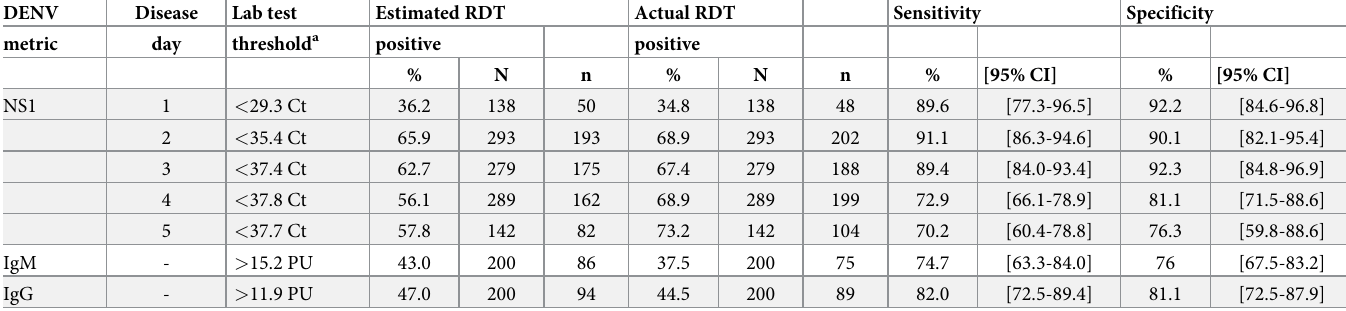
Table 1. Estimated laboratory-test values that yield RDT positive results compared to actual RDT outcomes. Estimated RDT positivity threshold refer to the optimal Youden’s J index value. Estimated/actual NS1 RDT positivity determined among patients from Vietnam (N: 1,217). Estimated/actual IgM/IgG RDT positivity determined among patients from Indonesia